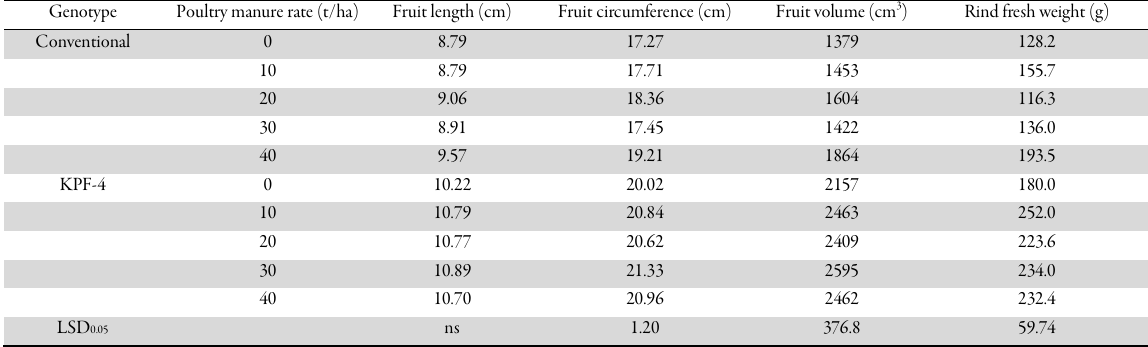
Table 4. Main effects of genotype and poultry manure rates on fruit metric traits of yellow passion fruit grown in the field in 2015 Genotype Conventional